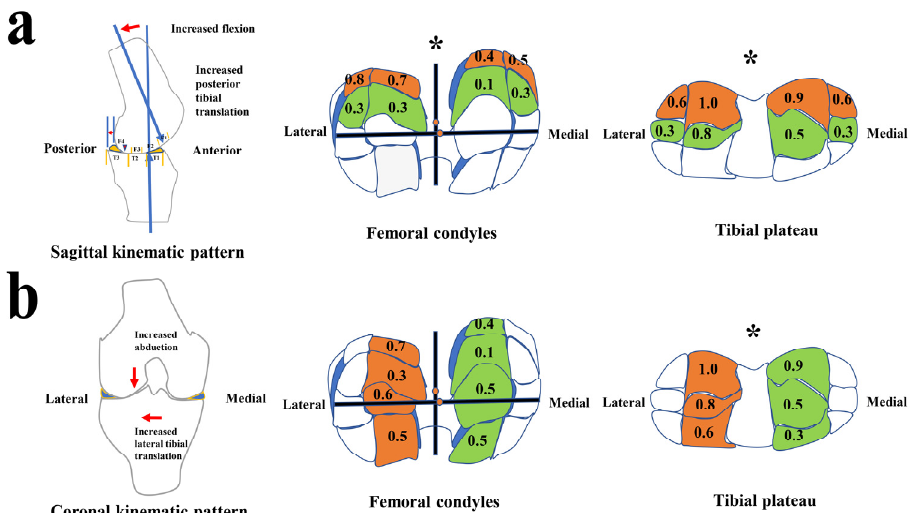
Figure 5. Diagram of a kinematic pattern that may accelerate the formation of cartilage lesions in ACLR knees: ( a , b ) Diagrams exhibit the kinematic action patterns and the evidence of ACLR knees with early CL. * Indicates significant CL severity distribution differences between sides ( p < 0.05).